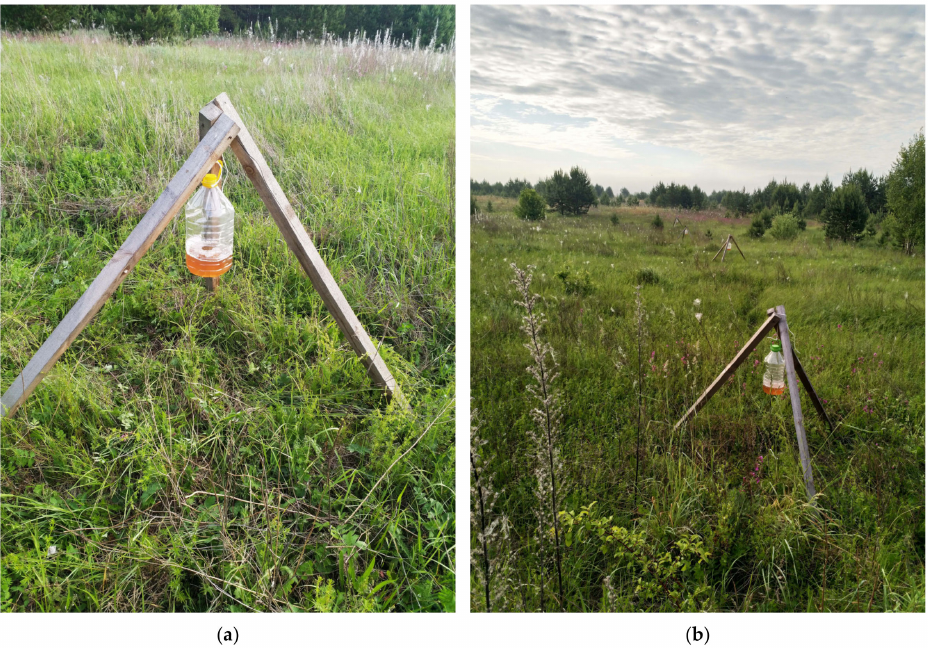
Figure 1. Different options for installing beer traps in open biotopes. ( a ) Single trap; ( b ) Installation of four traps in a row.